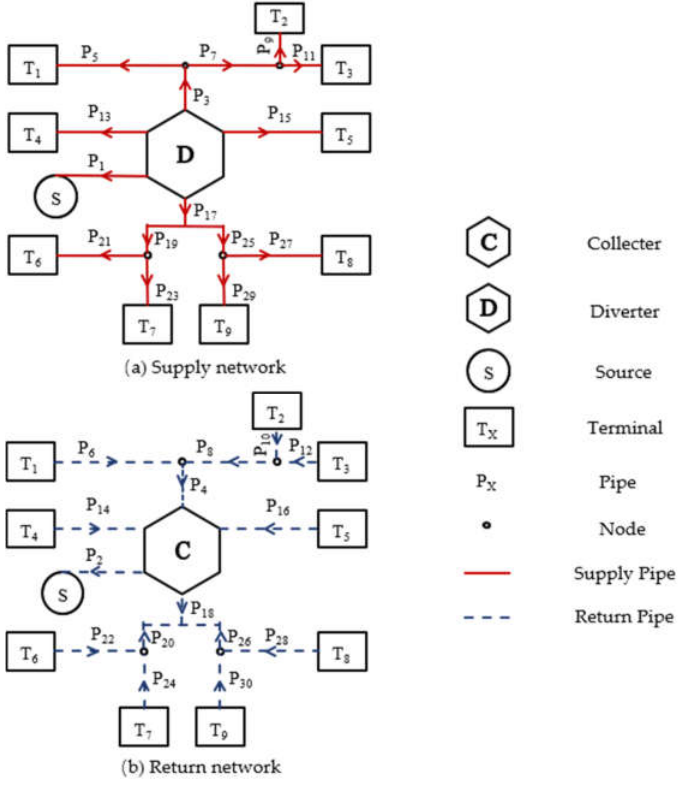
Figure 5. Supply and return of water in the ACWS